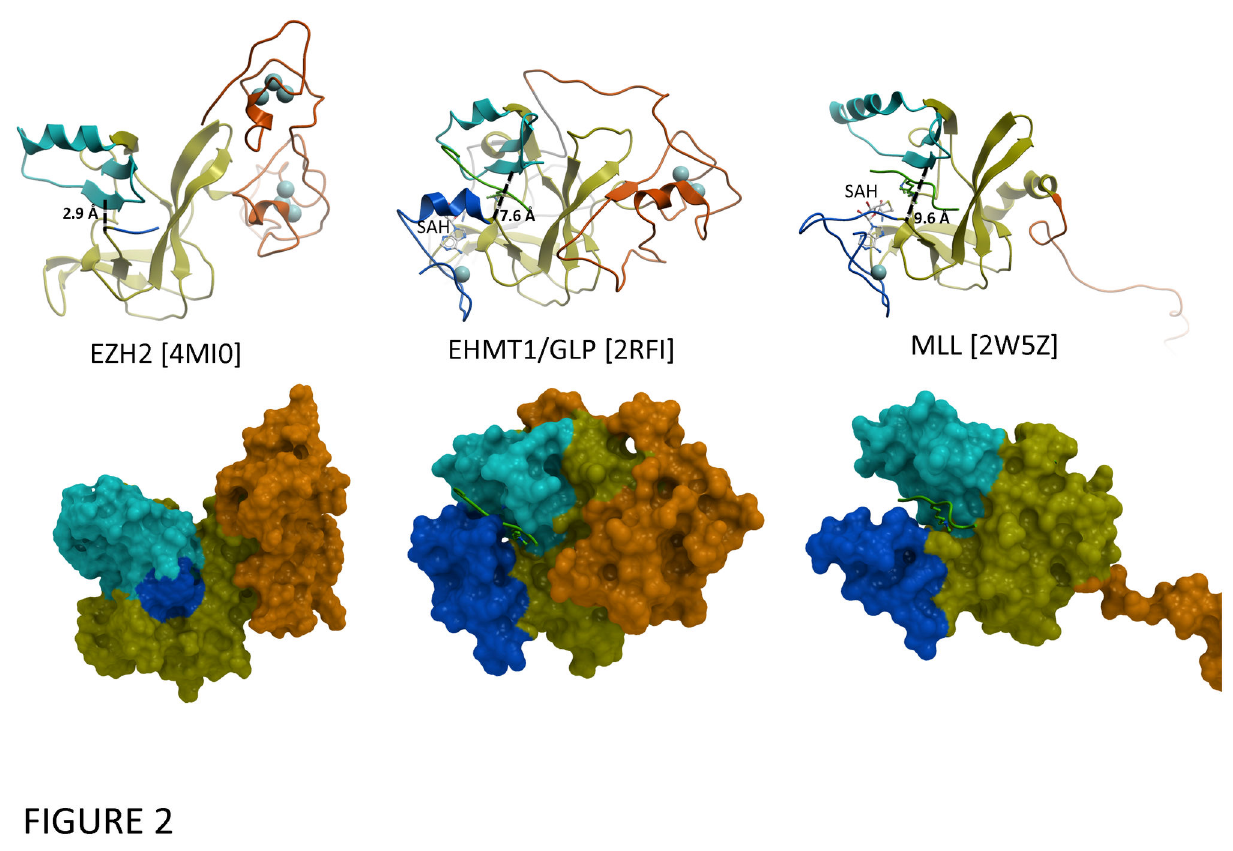
Figure 2. The substrate binding site of EZH2 is occluded. The substrate binding groove is too wide in MLL (right) and too narrow in EZH2 (left), compared with the catalytically competent state observed in the EHMT1/GLP ternary complex (center). Color- coding as in Figure